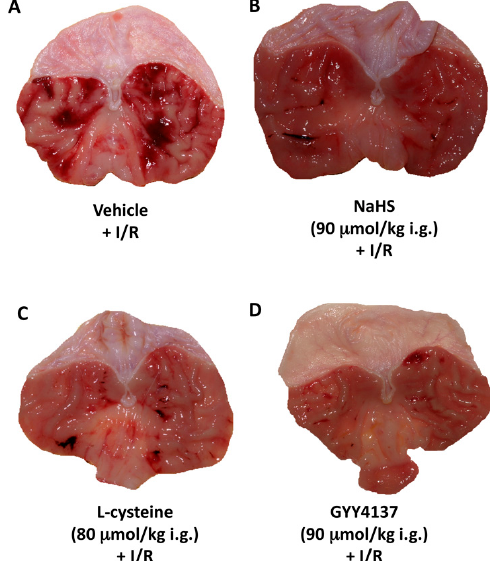
Figure 1. Gross macroscopic appearance of gastric mucosa pretreated 30 min prior to gastric ischemia-reperfusion (I/R) with vehicle ( A ); NaHS (90 μ mol/kg i.g.); ( B ), L -cysteine (80 μ mol/kg i.g.); ( C ) or GYY4137 (90 μ mol/kg i.g.); ( D ) and exposed to 30 min of I of celiac artery followed by 3 h of R (I/R). Pretreatment with NaHS (18–180 μ mol/kg i.g.) and L -cysteine (0.8–80 μ mol/kg i.g.) dose-